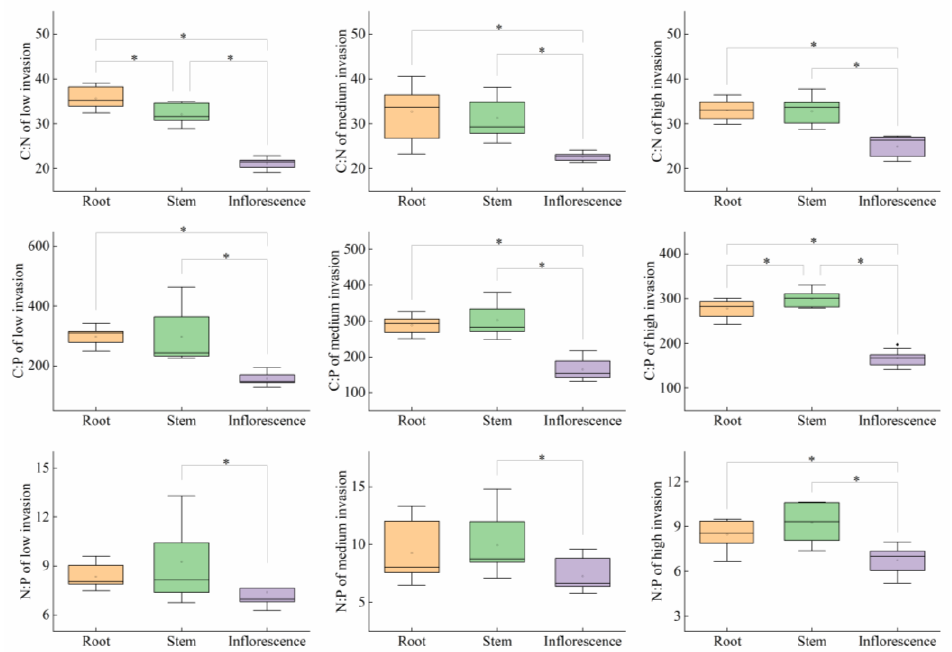
Figure 3. Differences of C:N, C:P, and N:P in structures of Pedicularis kansuensis within the same invasion level. * indicates a significant difference ( p < 0.05).